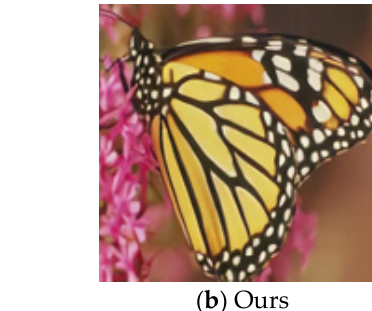
Table 4. Comparison on PSNR/SSIM obtained by different methods.